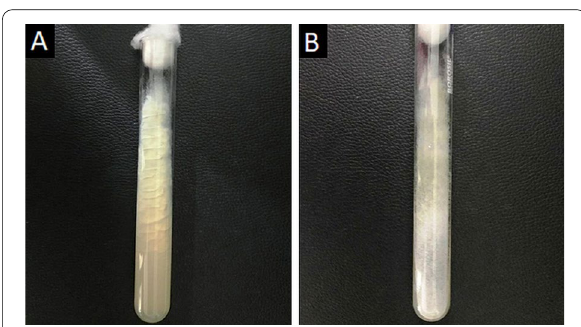
Fig. 4 Obverse ( a ) and reverse ( b ) views of Sabouraud Dextrose Agar used for the selective cultivation of Mucorales species at 30 the greyish white, cotton-like appearance of the fungal colonies